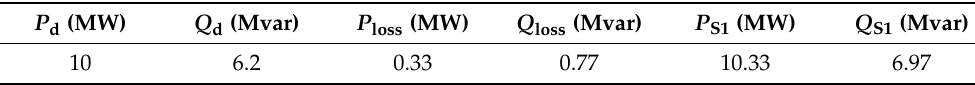
Table A2. Active and reactive power balance in the 4-bus network.